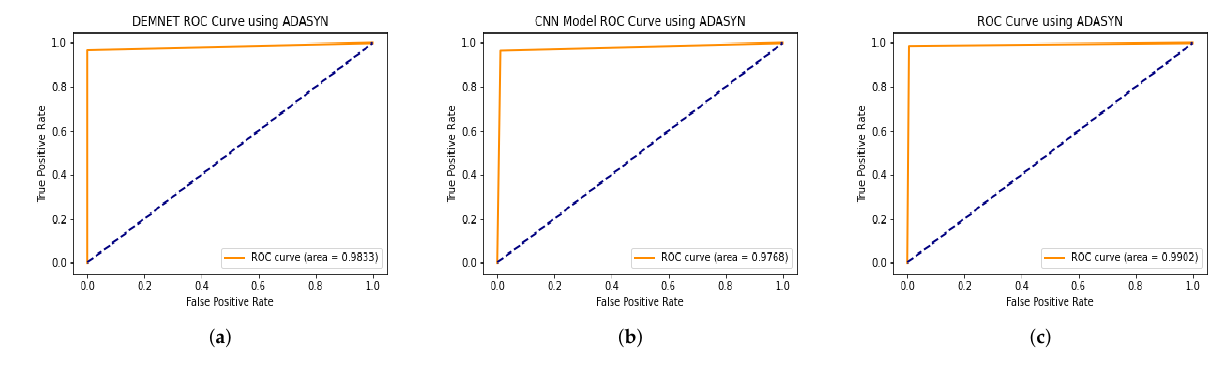
Figure 12. ROC Curve results of DEMNET, CNN Model, and DAD-Net using ADASYN. ( a ) DEMNET; ( b ) CNN Model; ( c ) Proposed DAD-Net.